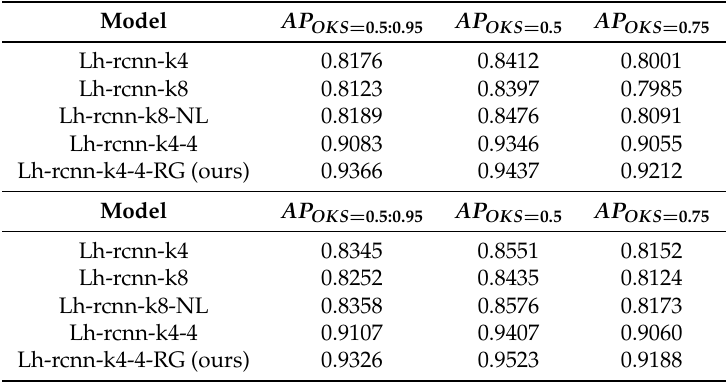
Table 2. Comparison of different keypoints head on simulation quadrotor dataset. (AP and AR represent the average accuracy and average recall, respectively. OKS indicates object keypoint similarity. For the explanations of each model, please refer to the